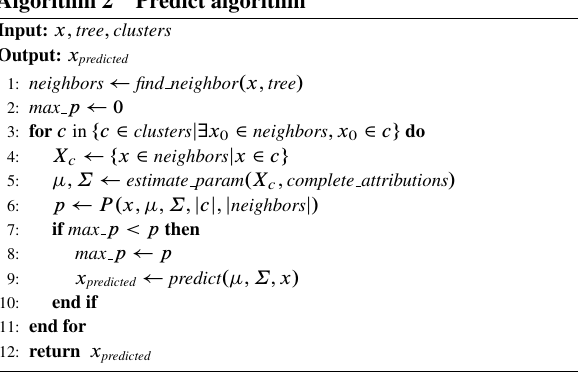
Algorithm 2 Predict